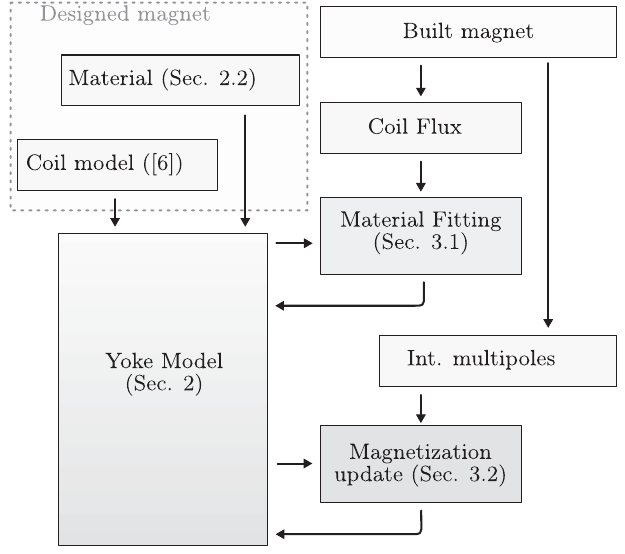
FIG. 1. Flow chart of the proposed data-driven